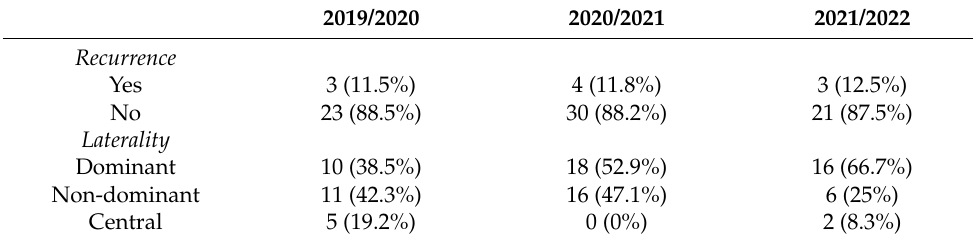
Table 6. Injury recurrence and laterality during three consecutive sporting